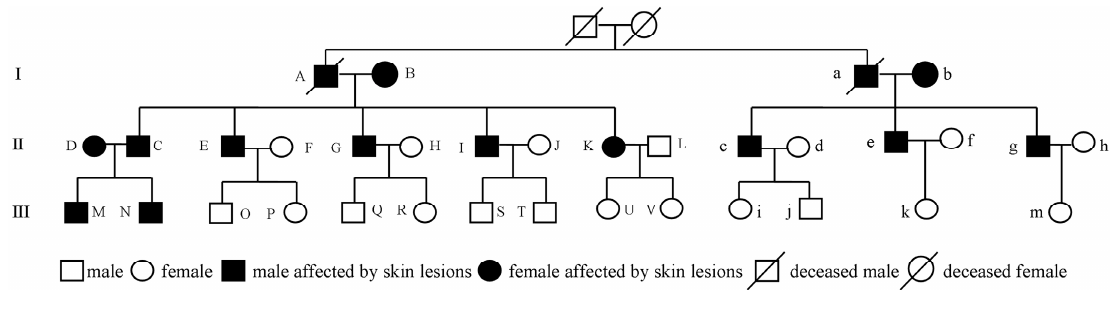
Figure 2. The pedigree tree of the family.